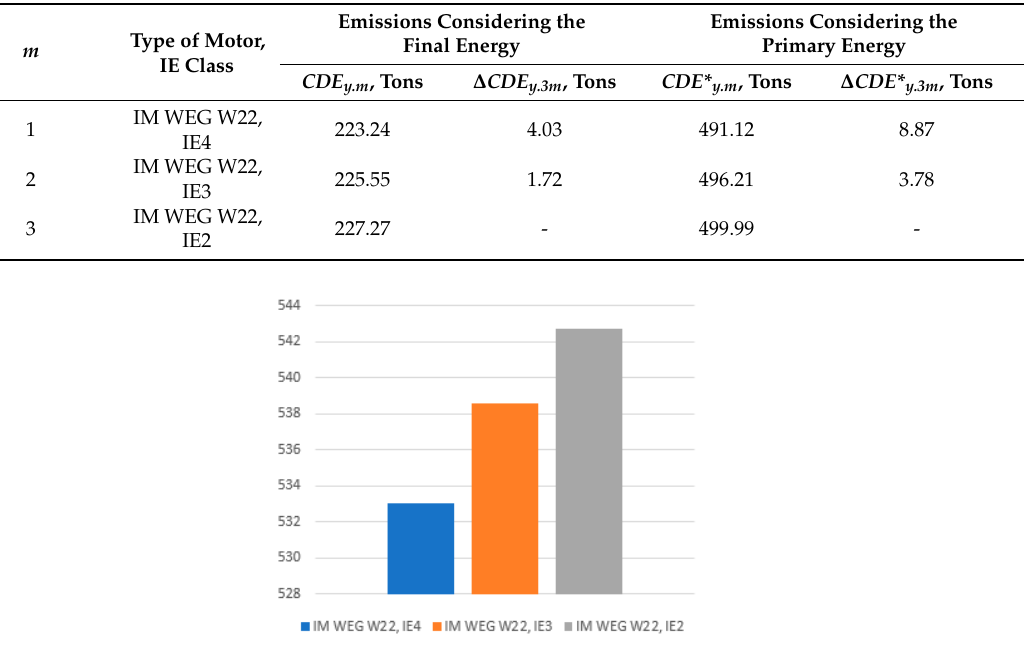
Figure 4. Annual energy consumption E y.m (MW · h).